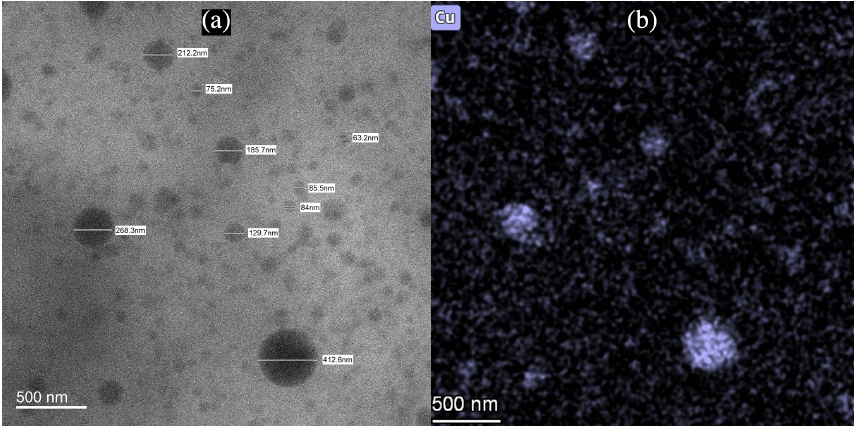
Figure 6. ( a ) TEM Image of CuNPs of Various Sizes in 15% PAN/DMF/CuNP Colloidal Solution ( b ) Elemental Distribution of Copper in TEM Image of 15% PAN/DMF/CuNP Colloidal